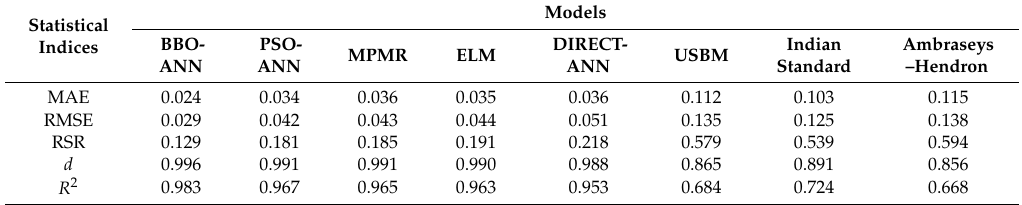
Table 7. Statistical indices obtained from the applied predictive models using training phase.